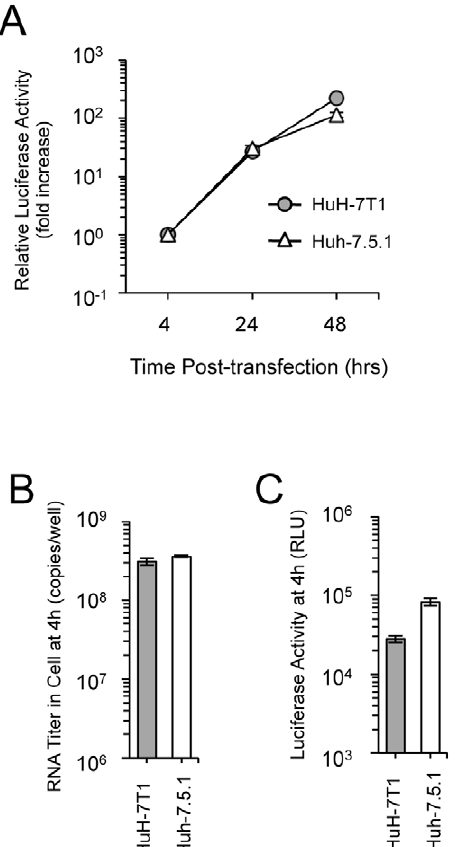
Figure 3. Comparison of replication in HuH-7T1 and Huh-7.5.1. (A) Five micrograms of JFH-1 subgenomic replicon RNA was electro- porated into HuH-7T1 and Huh-7.5.1. The cells were harvested at indicated time points. The luciferase activity in the cell lysates was normalized to the data at 4 h after transfection; values are expressed as fold increases. (B and C) Comparison of transfection and